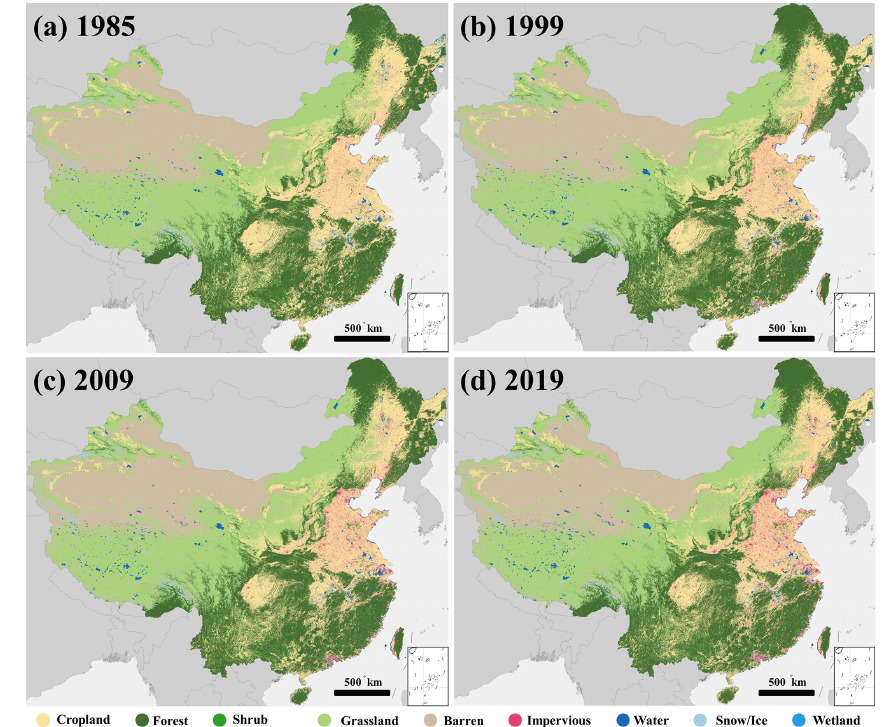
Figure 4. Annual China land cover dataset (CLCD) for 1985, 1999, 2009 and 2019.